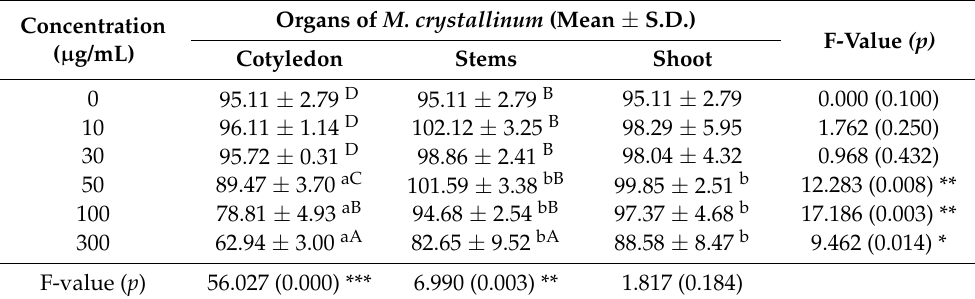
Table 8. Effects of ethanol extract according to the organ of the ice plant on IL-1 β levels in LPS-induced RAW 264.7